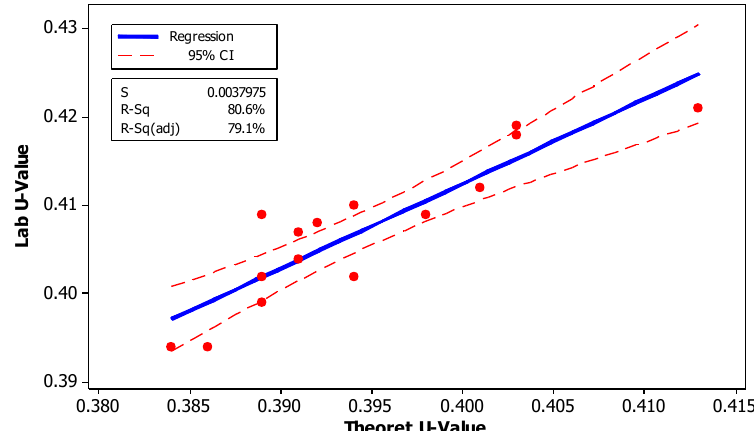
Figure 12. Contour plots between laboratory measurements and theoretical simulations. Theoretical simulation; U-Value, thermal transmittance coefficient.